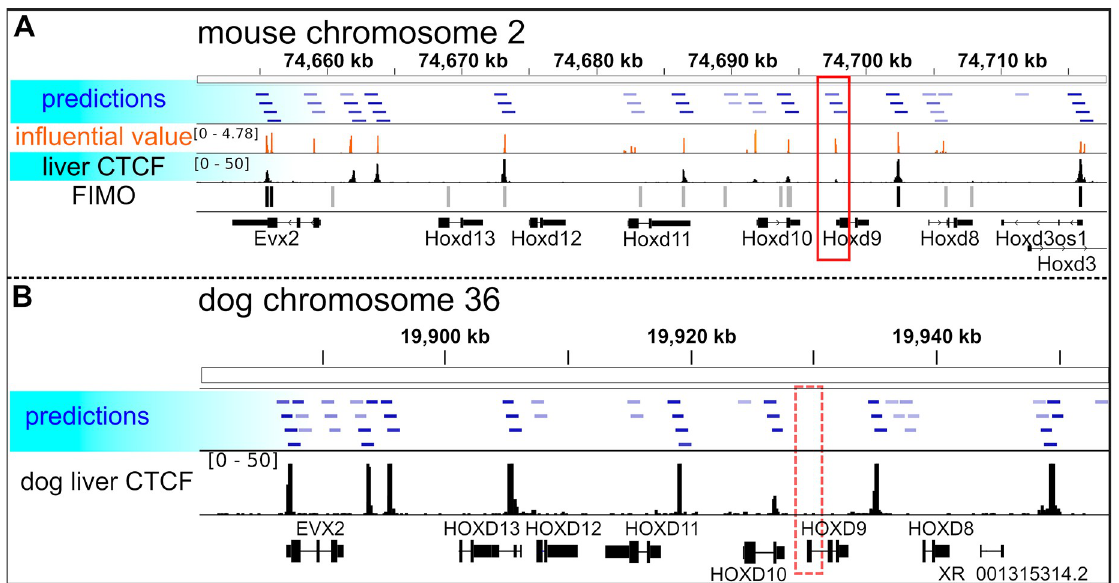
Fig 3. An example of CTCF binding site predictions on the HoxD cluster of mice and dogs. ( A ) Comparison between predictions by conv4-FRSS, experimaental data and motifs detected by FIMO in mouse chromosome 2 sequence. predictions, CTCF binding regions predicted by conv4-FRSS (prediction values � 0.2 are shown, and the bluer is more probable); influential value, values calculated with the class saliency extraction method; mouse liver CTCF, alignment data from ENCFF627DYN; FIMO, CTCF sites that were detected by FIMO (black boxes, p � 1e-4; gray boxes, 1e-4 < p � 1e-3). ( B ) Comparison between predictions by conv4-FRSS and experimaental data in the sequence of dog chromosome 36. dog liver CTCF, alignment data from ERR022304; red rectangles, a CTCF peak that is present in the mouse genome (solid rectangle) but not the dog genome (dashed